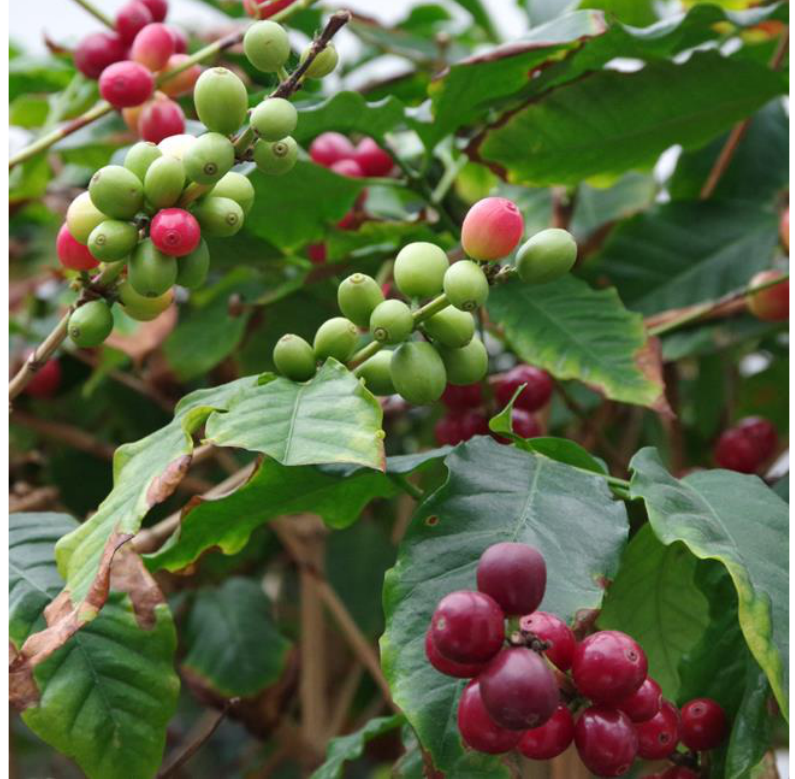
Figure 2. Coffee fruits in different stages of ripeness. Various functions of trigonelline in planta have been proposed, such as serving as a nutrient source and compatible solute, involvement in cell cycle regulation by arresting the G2 phase, signal transduction, nyctinasty (orientation of a plant’s leaves, flowers, cotyledons, or branches toward the light source to maximize photosynthesis [33]), and nodulation